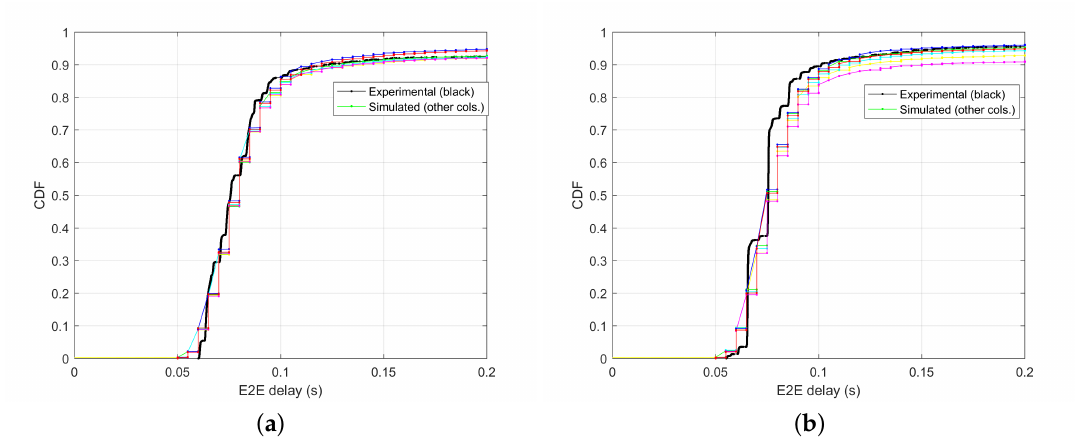
Figure 14. Comparison of E2E delay CDF generated from the model with the corresponding experimental CDF: Two different measured samples on the same railway section (all available radio access technologies).